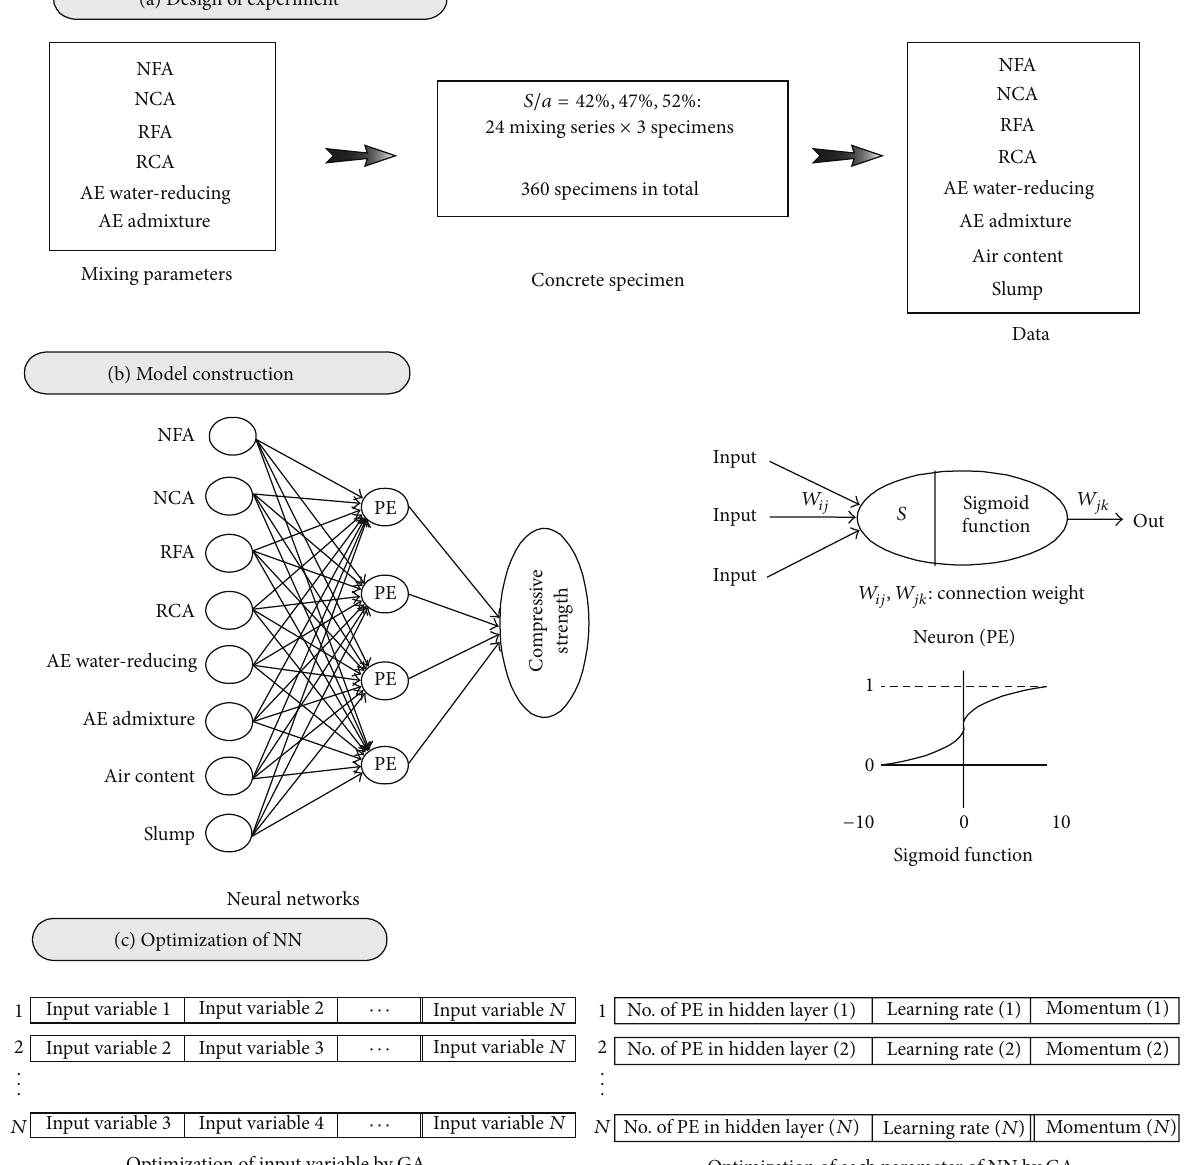
Figure 1: The three steps of this study for RAC mixing. (a) Each factor and S/a value of NAs and RAs were used to construct the NN model using how they satisfied the concrete performance criteria (e.g., slump, air content, admixture, and compressive strength), and how they matched the selected factor to receive the factor’s optimum value. (b) Each factor’s value obtained in “ a ” was applied to the NN input and output variables. The neuron that received the input value displayed the output value using a connection weight. This time and connection weight were calculated using a sigmoid transfer function. (c) The GA was applied to optimize each NN parameter (e.g., momentum, learning rate of the NN, and number of neurons in the hidden